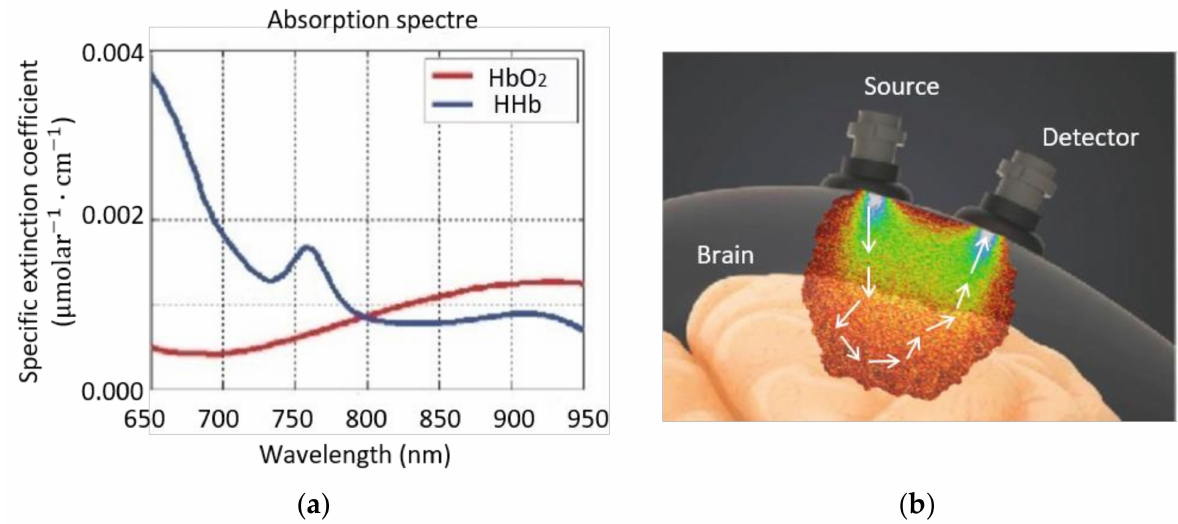
Figure 5. ( a ) Absorption coefficient spectra of oxyhemoglobin (HbO 2 ) and deoxyhemoglobin (HHb). ( b ) The probabilistic trajectory of photons from the source to a detector of incident near-infrared light is described as a “banana shape” [38]. Figure modified from